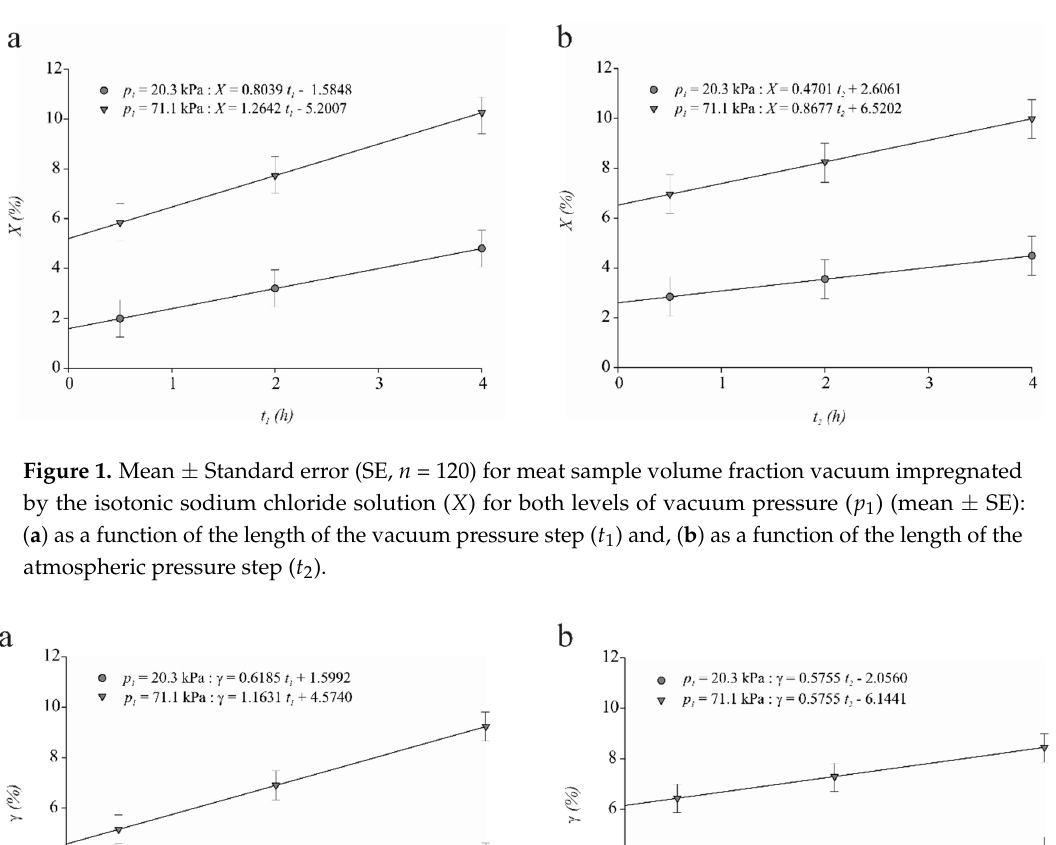
pressure ( (cid:1868) (cid:2869) ): ( a ) as a function of the length of the vacuum pressure step ( (cid:1872) (cid:2869) ) and ( b ) as a function of pressure ( p 1 ): ( a ) as a function of the length of the vacuum pressure step ( t 1 ) and ( b ) as a function of the length of the atmospheric pressure step ( (cid:1872) (cid:2870) ). the length of the atmospheric pressure step ( t 2